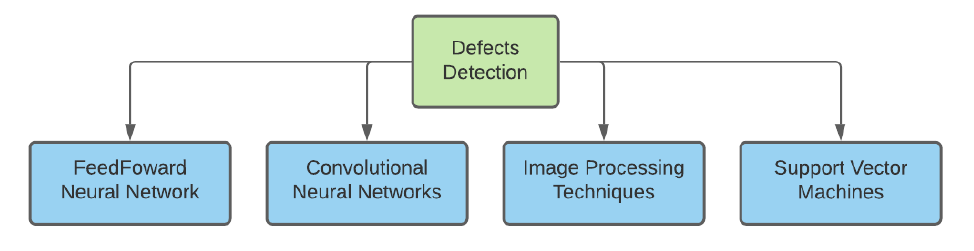
Figure 7. Most used IA method for defect